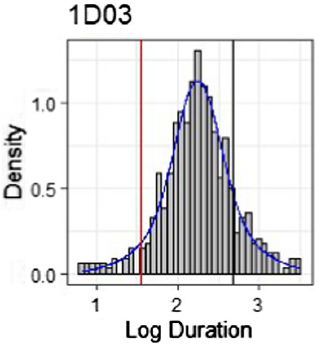
FIG. 3. Histogram and FMM fit profile for log attempt duration of module 1D03. The black line represents the cutoff originally determined by the algorithm based on a two-component fit, and the red line represents the adjusted cutoff (35